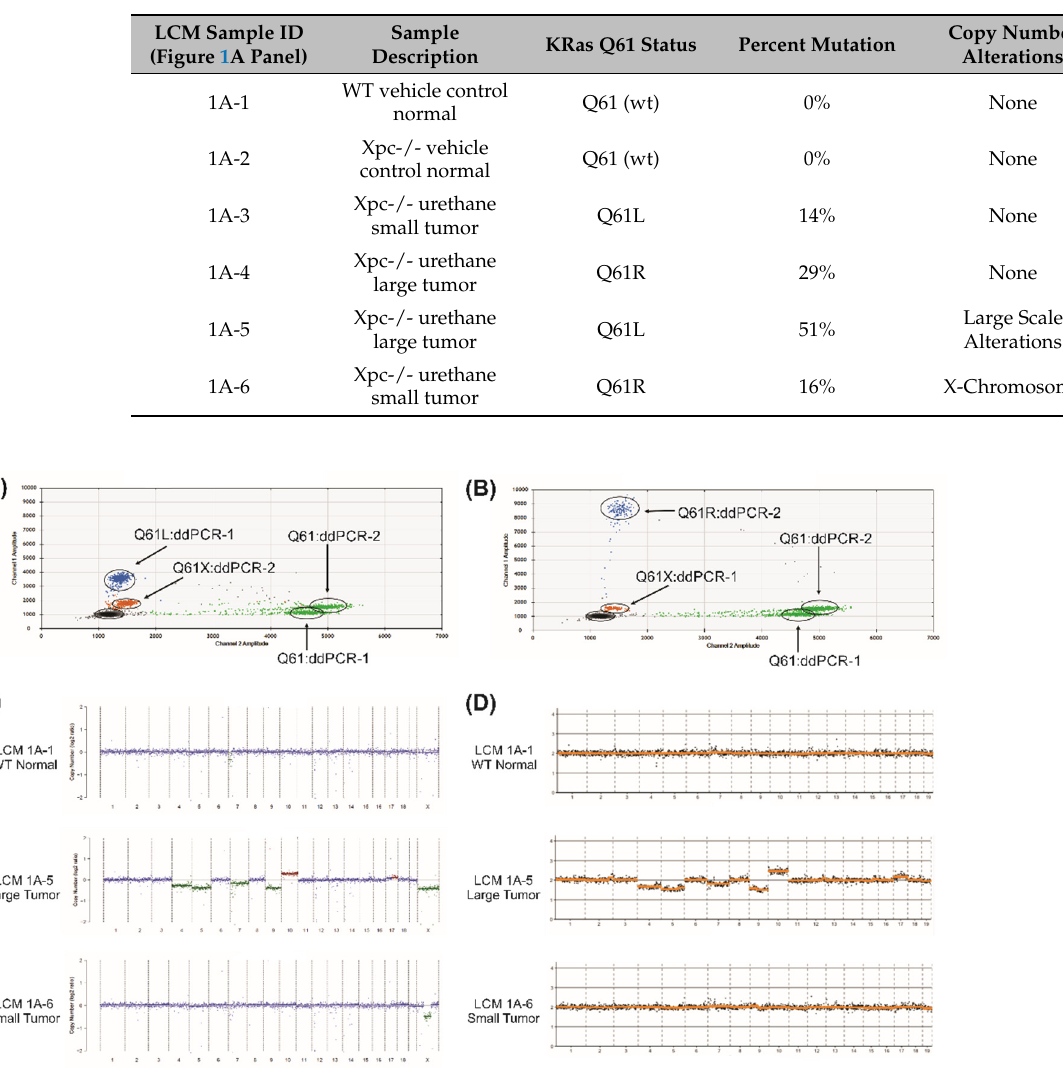
Figure 2. Typical ddPCR and CNA identified by LC-WGS. ( A ) Kras Q61 ddPCR-1 and ddPCR-2 sample 1A-5 (Xpc-/-, urethane treated). ddPCR-1 assay (to detect Kras Q61L) shows both WT Kras (green) and Kras Q61L (blue) gDNA in this sample. ddPCR-2 assay (to detect Kras Q61R) confirms the nearby mismatch Kras sequence already identified as Kras Q61L by ddPCR-1 (orange signal). ( B ) Kras Q61 ddPCR-1 and ddPCR-2 assays on small tumor sample 1A-6 (Xpc-/-, urethane treated). ddPCR-2 assay (to detect Kras Q61R) shows a mixed gDNA composition of WT Kras (green) and Kras Q61R (blue) in this sample. ddPCR-1 assay (to detect Kras Q61L) confirms the nearby mismatch Kras sequence, already identified as Kras Q61R by ddPCR-2 (orange signal). ( C ) CNA analysis of LCM samples from LC-WGS data using ichorCNA to estimate copy number across the mouse genome including the sex chromosomes. Control